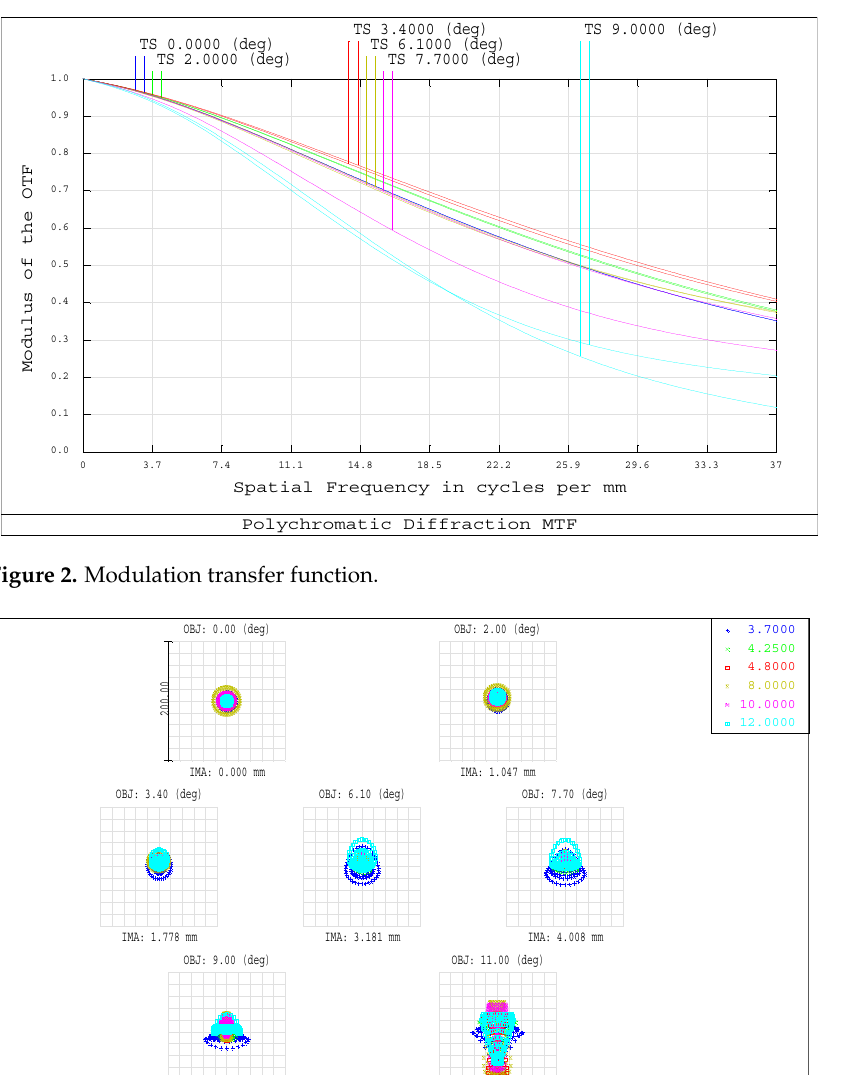
Figure 4. Assembled wide band infrared lens.